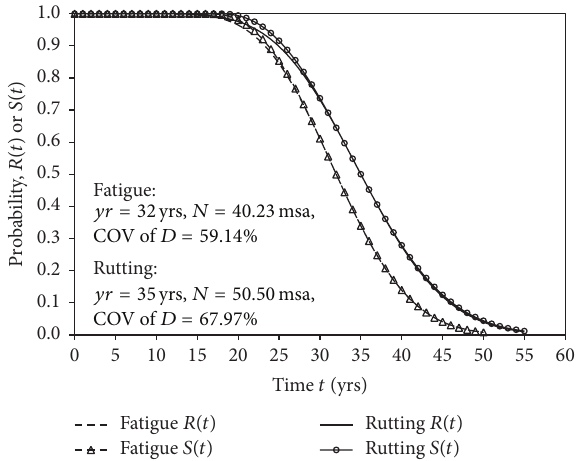
Figure 2: Hazard function with different design